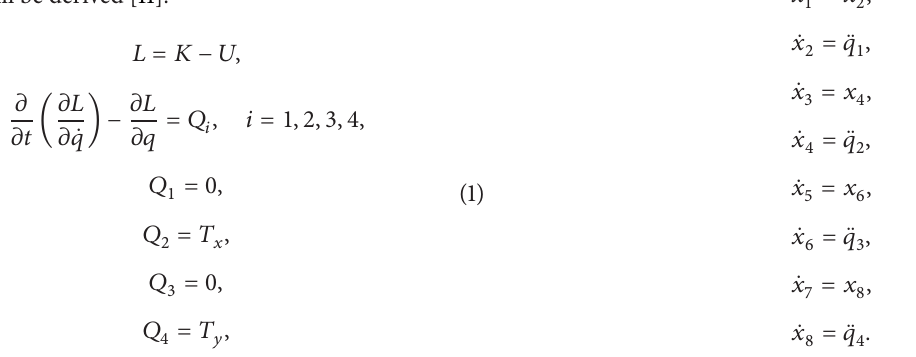
friction is large enough [10]. The system parameters are 𝜃 𝑥 , 𝛽 𝑥 which, respectively, denote the ball and the spheres angles with respect to the 𝑥 direction, 𝜃 𝑦 , 𝛽 𝑦 which denote the ball and the spheres angles with respect to the 𝑦 direction, 𝐼 𝐼 𝑅 and 𝑟 which are moments of inertia of the sphere and ball, respectively, and 𝑚 as the balls mass. There are also 𝑅 and 𝑟 which already denote the sphere and balls’ radiuses,